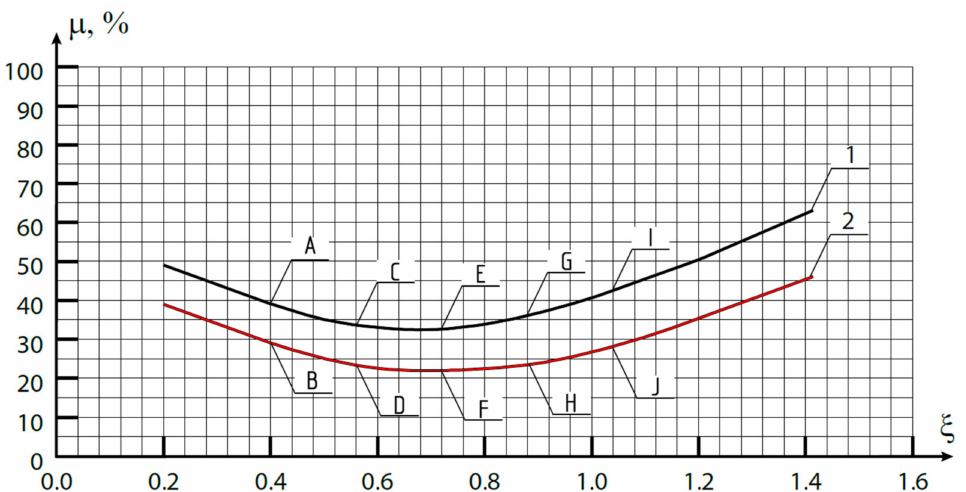
Figure 6. Dependence of the degree of distortion of the vortex signal formed by the V-FBG on the nature of apodization of the periodic structure: 1— ∆ n = 0.01 n 0 and 2— ∆ n = 0.001 n 0 ; points A and B correspond to the angle ∆ ϕ = 0.2%; C and D— ∆ ϕ = 0.13%; E and F— ∆ ϕ = 0.08%; G and H— ∆ ϕ = 0.01%; I and J— ∆ ϕ = 0.09%; ξ = | Φ LP 11 / Φ LP 01 | . The angle was calculated as a percentage relative to 2 π (2 π = 100%).